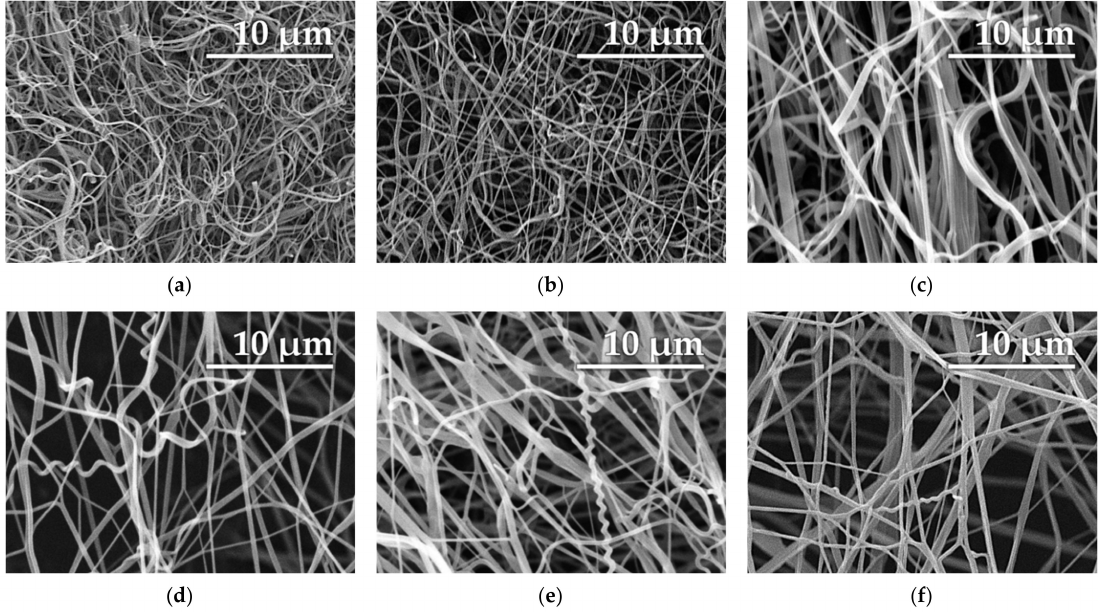
Figure 7. SEM images of the prepared PA 6 nanofibers: the basic PA 6 solution exposed to the sinus wave ( a ) and the step change ( b ), the PA 6 solution enhanced with sulfuric acid exposed to the sinus wave ( c ) and the step change ( d ), and the PA 6 solution enhanced with methane-sulfonic acid exposed to the sinus wave ( e ) and the step change ( f ). The images indicate a minimal change in the morphology compared to the two enhanced